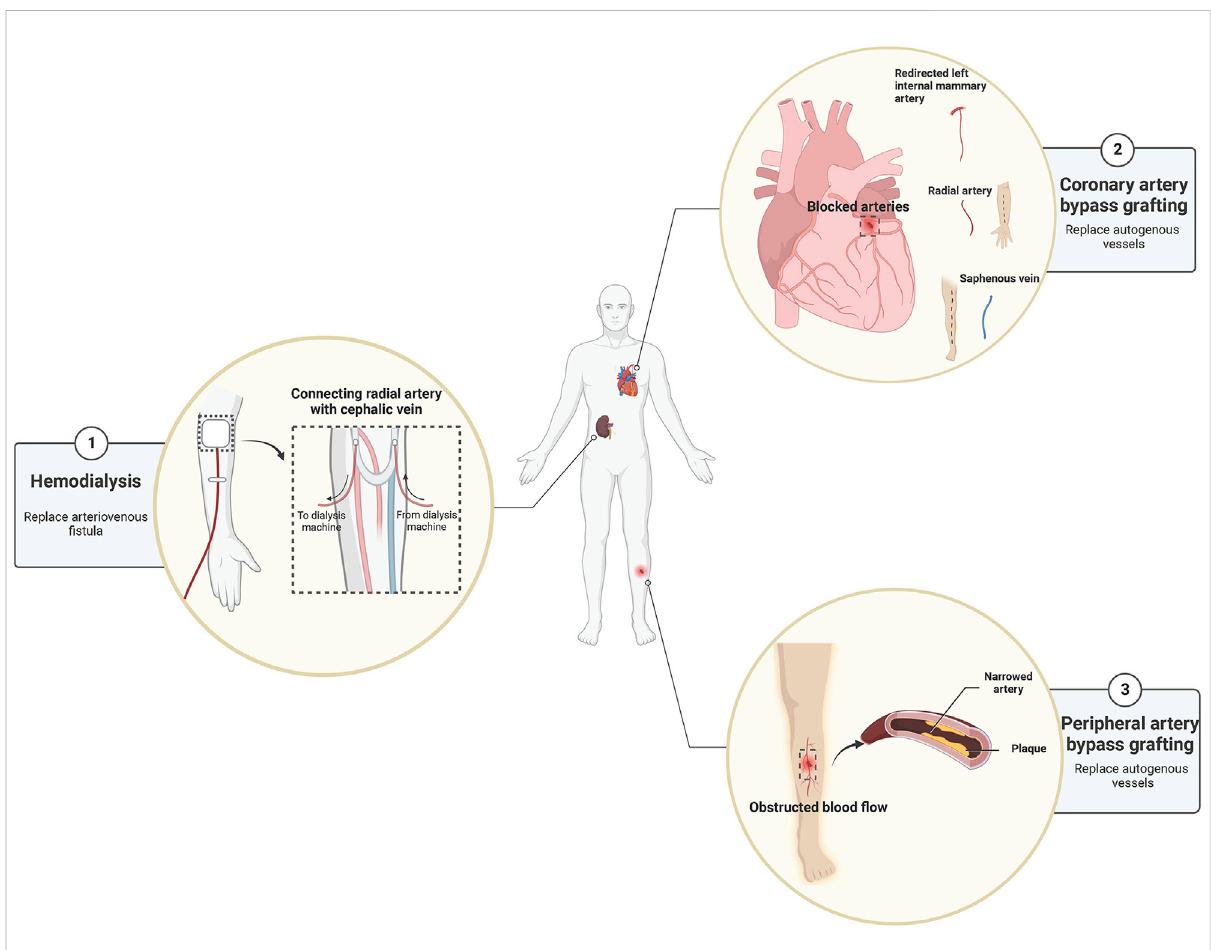
FIGURE 7 The prospects of the use of the decellularized vascular matrix in small-diameter vascular